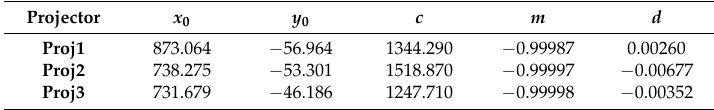
Table 6. Projector interior orientation (units in (pixels) for x 0 , y 0 and c ).